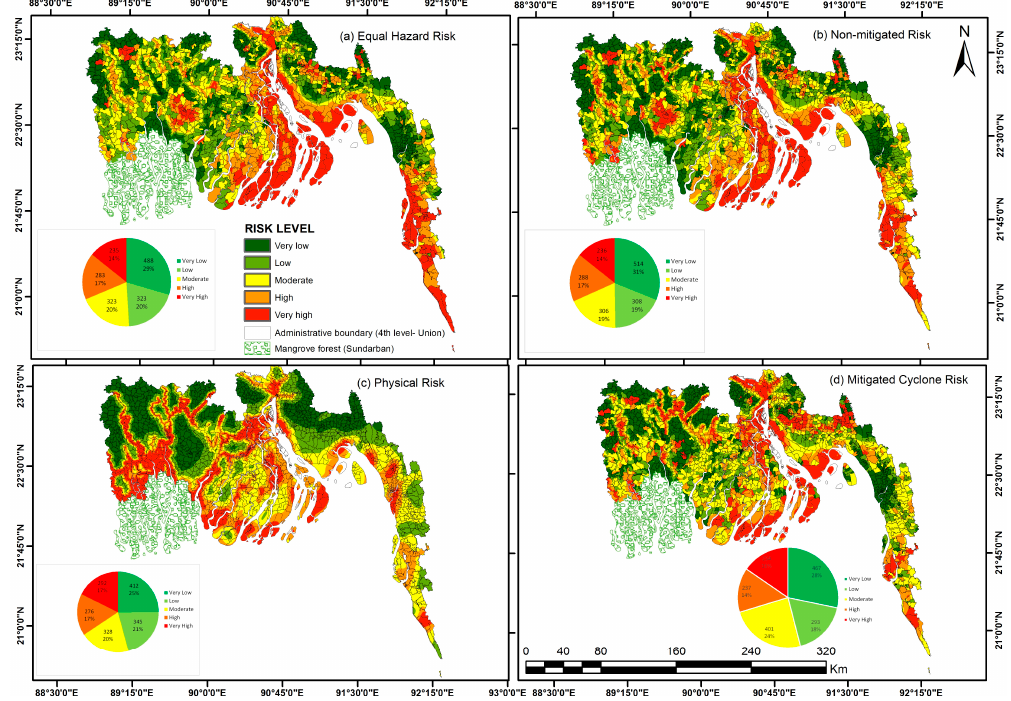
Figure 8. Risk Map of the study area: ( a ) Equal hazard Risk index was calculated by multiplying exposure and vulnerability; ( b ) Non-mitigated Risk index was calculated by multiplying hazard, exposure and vulnerability; ( c ) Physical Risk index was calculated by multiplying hazard and exposure; ( d ) Mitigated Risk index was calculated by multiplying hazard, exposure, and subtract of capacity from vulnerability.